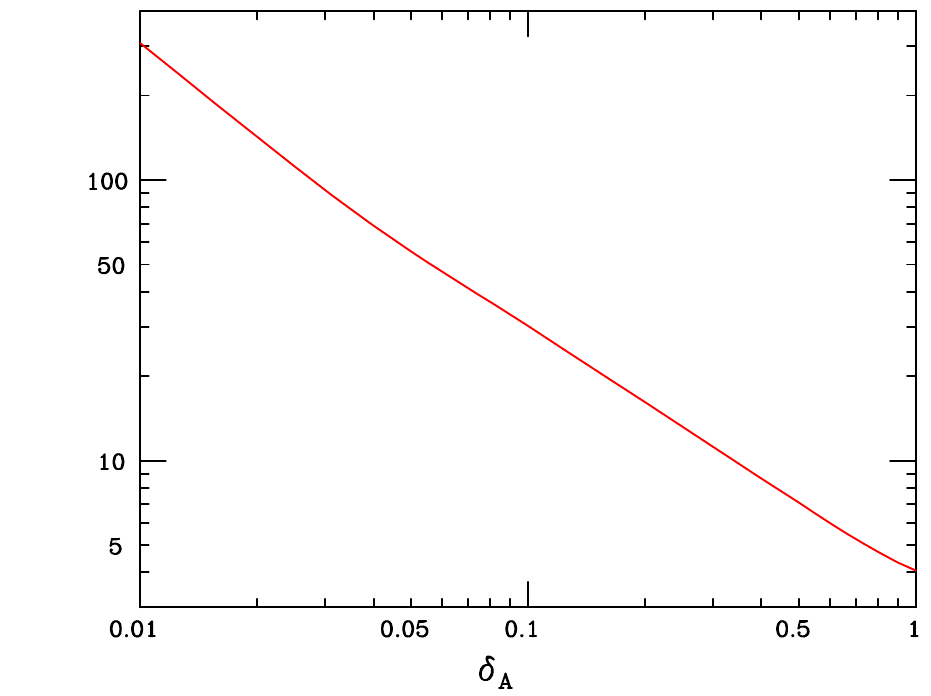
Figure 4 . The dependence of the (normalized) sum over the (cid:15) 2 described in the